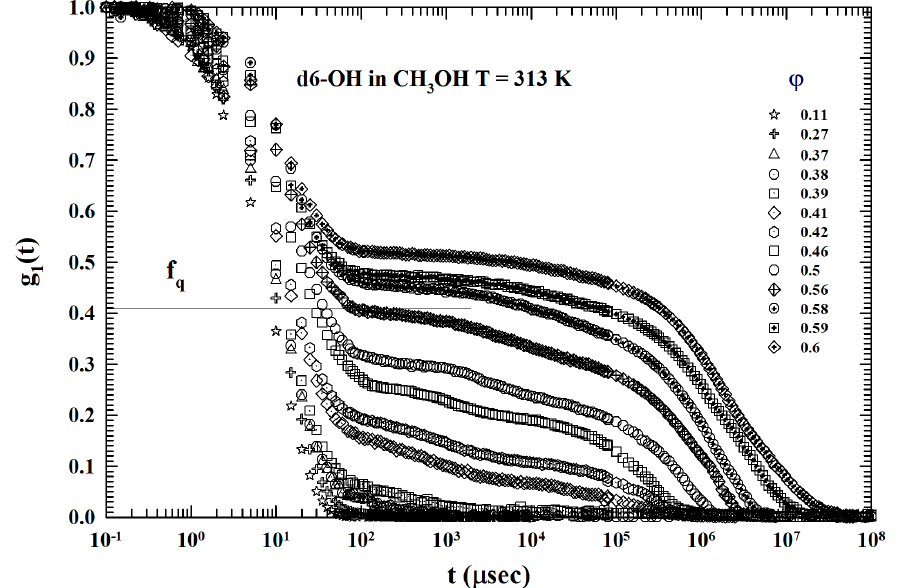
Figure 7. The ISFs of the g = 6 dendrimer dissolved in methanol at 313 K. In this case, none of the illustrated ISFs show the AHS logarithmic decay. Thus, the system appears to be fully dominated by